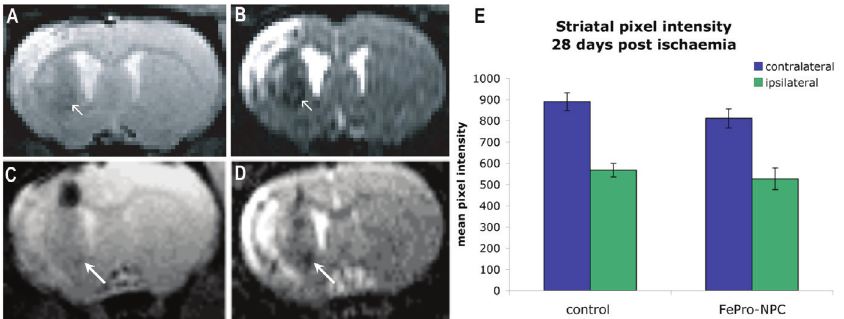
Figure 5. Hypointensity at 28 days post-ischaemia. T - ( B , D ) and T *-weighted ( A , C ) images are shown. A , B , MCA region in one control. 2 2 C , D . MCA region in one FePro-NPC animal at 28 days post-ischaemia. Hypointense regions within the ischaemic lesion (arrows) were observed in both T - and T *-weighted images. E , Signal intensity in regions of T -weighted hypointense ipsilateral striatum at 28 days post-ischaemia, 2 2 2 and in corresponding contralateral regions in control (green) and FePro-NPC (blue) groups. Signal intensity in the ischaemic striatum was lower than in the contralateral striatum. Signal intensity was significantly different between contralateral and ipsilateral hemispheres (p<0.001).